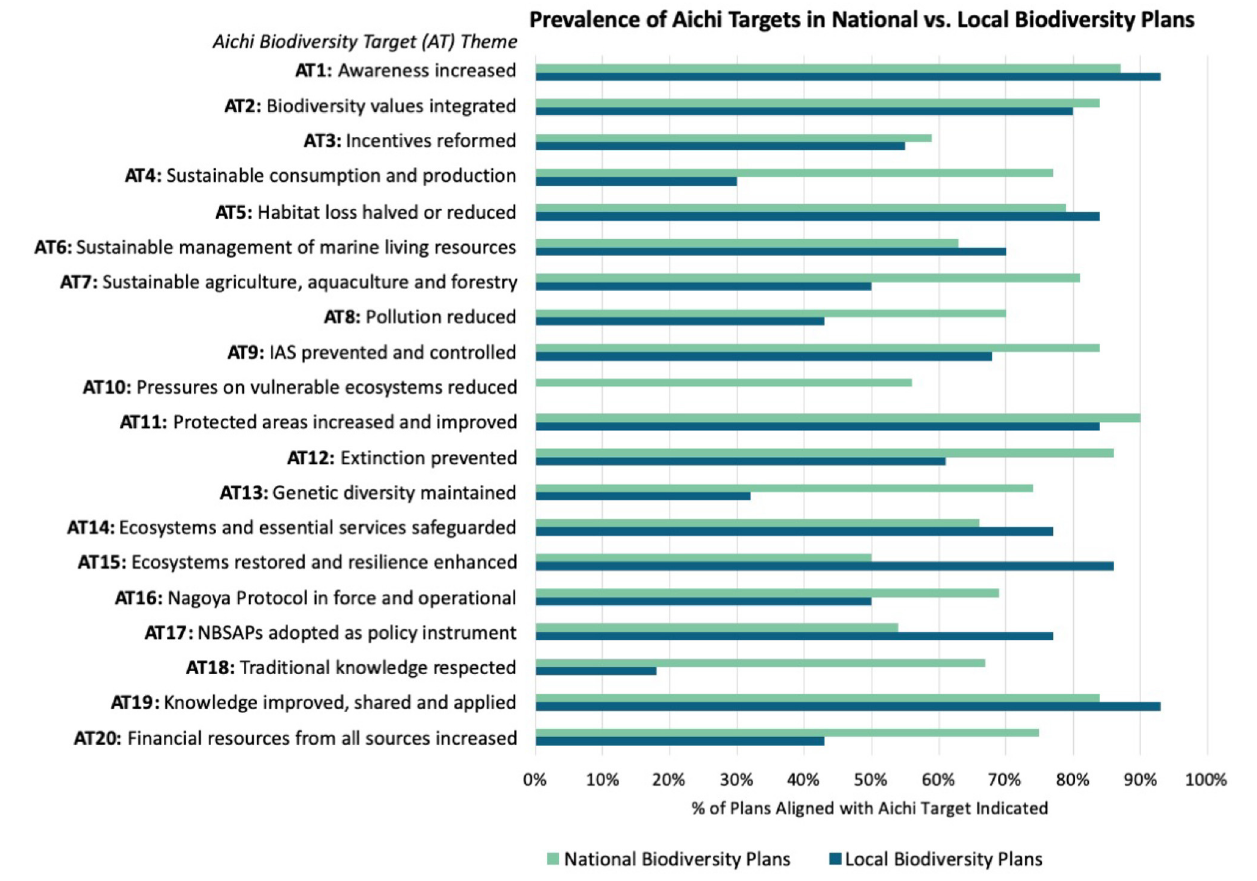
FIGURE 3 | Prevalence of Aichi Targets in local and national biodiversity plans. Data for national plans was extracted from the 5th Global Biodiversity Outlook (Secretariat of the Convention on Biological Diversity, 2020).